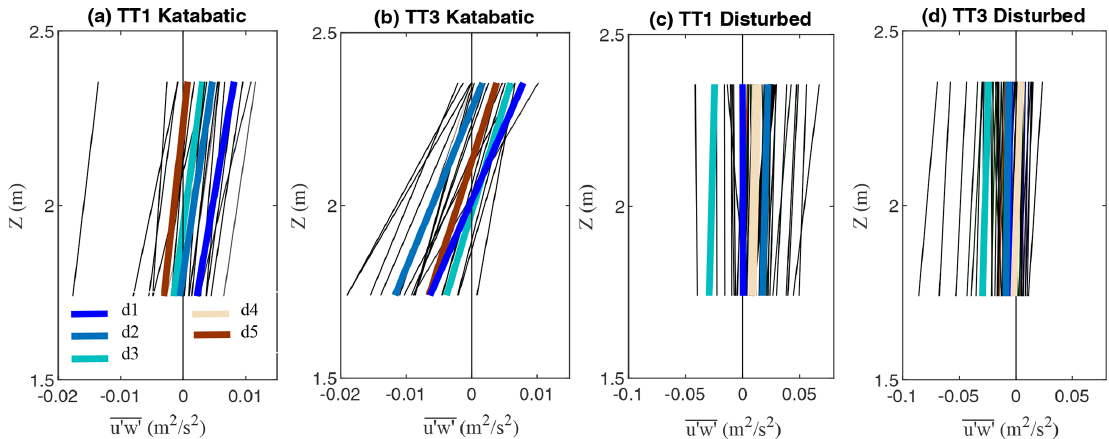
Figure 6. Profiles of 30min and daily (bold) averages of streamwise momentum flux ( u (cid:48) w (cid:48) ) measured during purely katabatic-flow and during disturbed-flow conditions at transect stations TT1 and TT3. Note that only 30min averaged data were considered to be purely katabatic if data showed katabatic flow during the entire 30min periods. Colours of bold lines indicate different measurement days.